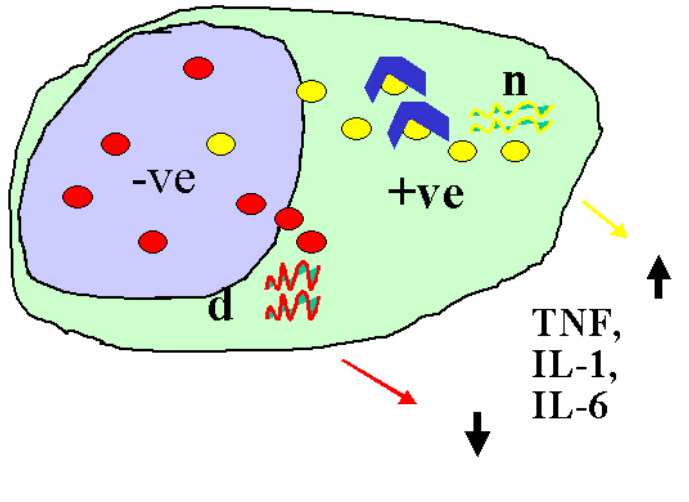
FIGURE 1 . Schematic illustration of the mechanistic differences between RanT/n and RanC/d. The single point mutation of Ran mRNA leads to different intracellular localization of the two species of Ran mRNA and protein[15]. There is no significant difference in transcriptional and translational rates. The preferred cytoplasmic localization of RanT/n proteins renders them susceptible to enzymatic degradation by proteases located in the cytoplasm. All cytoplasmic Ran proteins transmit a positive signal to activate transcription of proinflammatory cytokine genes; all nuclear Ran proteins produce a negative signal. Thus, RanT/n-transduced cells would produce an overall positive signal for the production of proinflammatory cytokines, whereas for RanC/d-transduced cells, a down-regulation of cytokine production. Yellow wiggly lines and circles, RanT/n mRNAs and proteins, respectively; red wiggly lines and circles, RanC/d mRNAs and proteins; filled blue shape, cytoplasmic protease; +ve or -ve = positive or negative signal transmission for proinflammatory cytokine production. Black up or down arrows = increase or decrease levels of TNF, IL-1, and